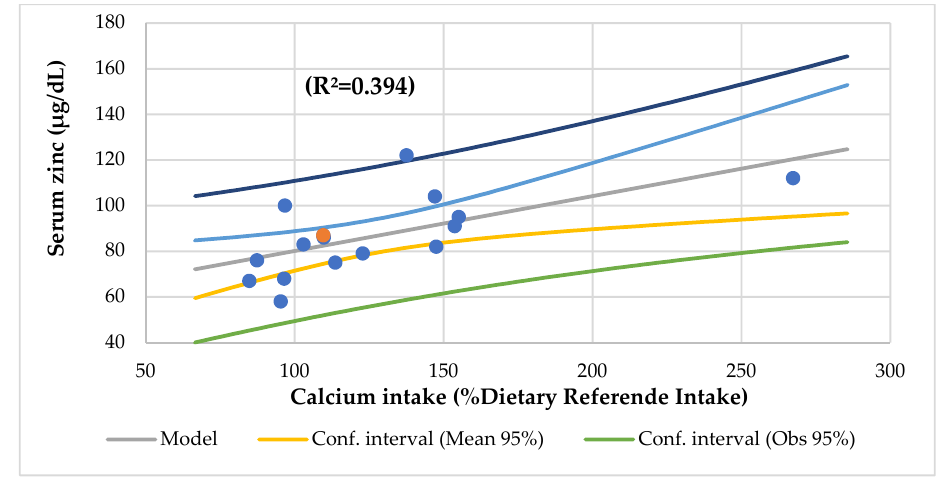
Figure 5. Regression serum total proteins (g/dL) by serum calcium (mg/dL).